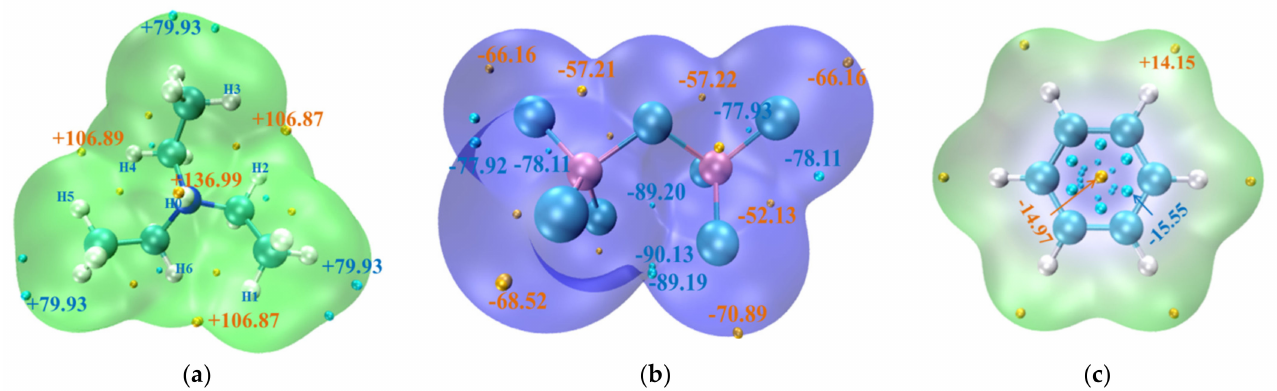
Figure 7. Electrostatic potential mapped molecular vdW surface of calculated by B3LYP/6-311++G(d,p) for ( a ) Et 3 NH + ; ( b ) Al 2 Cl 7 − and ( c ) C 6 H 6 . Green and blue represent positive and negative electrostatic potential distribution respectively. The yellow and green points represent the maximum and minimum values of electrostatic potential respectively.